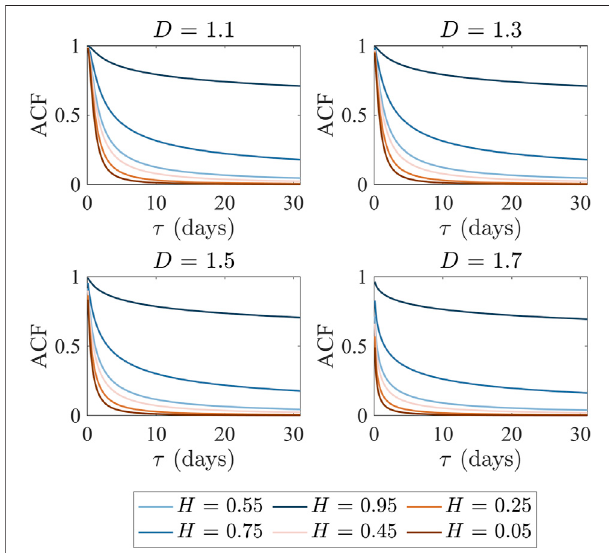
FIGURE 2 | Simple examples of the generalized Cauchy model with various values of D and H